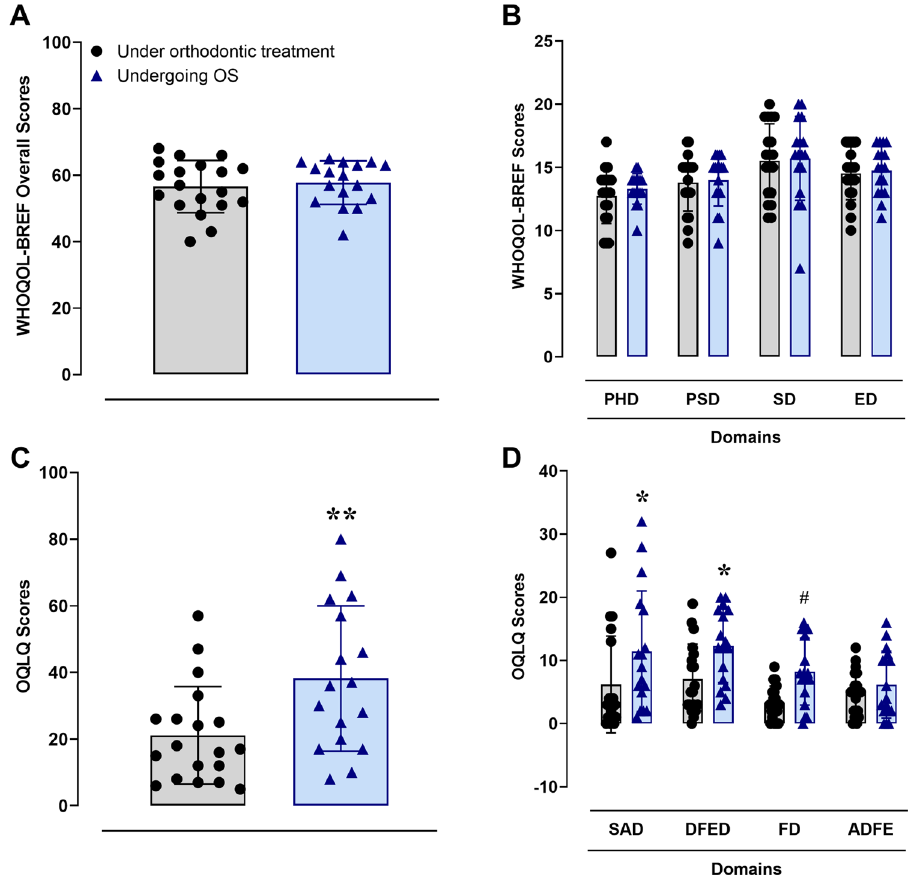
Figure 1. World Health Organization QoL Scale (WHOQOL-BREF) total scores ( A ), WHOQOL-BREF domain scores ( B ), Orthognathic QoL Questionnaire (OQLQ) total scores ( C ), and OQLQ domain scores ( D ), for the control (n = 19) and test (n = 17) groups. For the WHOQOL instruments, the Unpaired Student’s t-test ( A ), and Two-Way ANOVA ( B ) were performed. As for the OQLQ tests, the Unpaired Student’s t-test ( C ), and Two-Way ANOVA followed by Sidak’s test ( D ) were performed, where the test group was significantly different from the control group (* p < 0.05; ** p < 0.01; # p = 0.054). Each column represents the mean ± SD, and the N of each group is depicted in the scatter dot plots. The WHOQOL domains were the physical health domain (PHD), the psychological domain (PSD), the social domain (SD) and the environment domain (ED). The OQLQ domains were the social aspects domain (SAD), the dentofacial esthetics domain (DFED), the function domain (FD), and the awareness of dentofacial esthetics